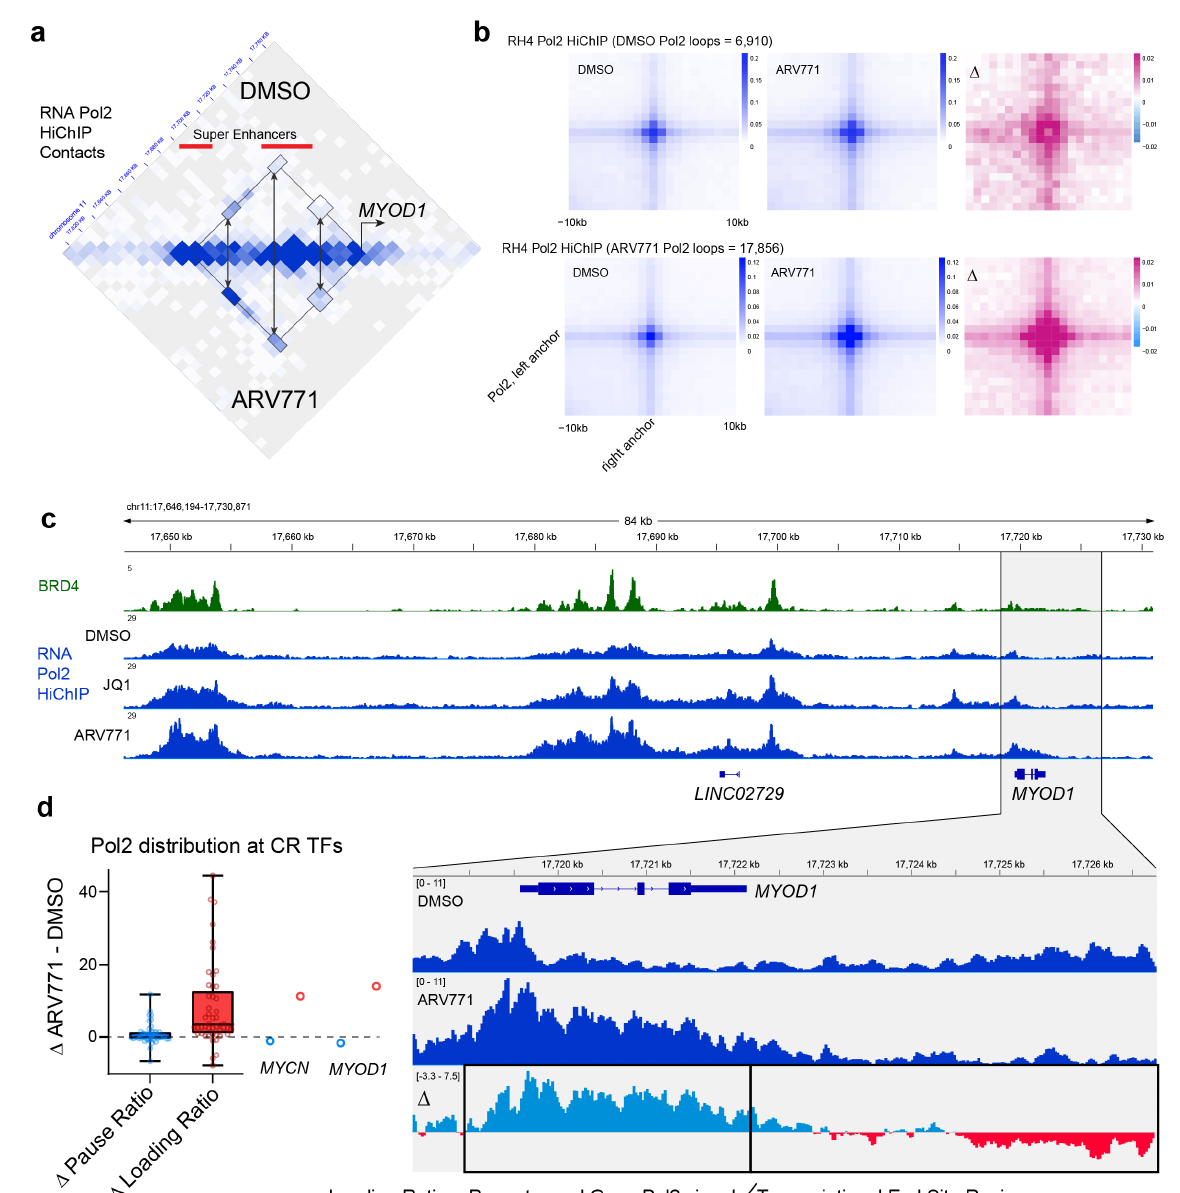
Figure 2. Pol2 redistribution upon the loss of BET bromodomain proteins. ( a ) Contact matrix of RNA Pol2 AQuA-HiChIP in RH4 treated with DMSO (top) or ARV-771 (bottom). H3K27ac defined super enhancers are annotated with red lines. Color scales from gray to blue indicate the number of contacts connecting distal genomic sites. ( b ) Aggregate peak analysis of Pol2 loops called in DMSO- (top) or ARV-771-treated RH4 cells (bottom). Scales are in contacts per million per loop and are AQuA-normalized. ( c ) Genome browser tracks for BRD4 ChIP-seq (top) and RNA Pol2 HiChIP in RH4 treated with DMSO, JQ1, or ARV-771. ( d ) RNA Pol2 distribution changes upon ARV-771 treatment, measured by changes in the pause ratio or loading ratio. Data plo tt ed are from Pol2 HiChIP at FP-RMS CR TFs (core regulatory transcription factors).